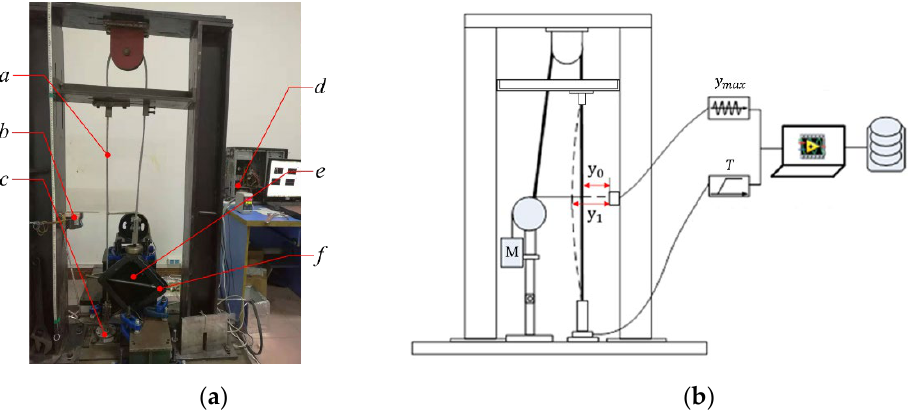
Figure 9. Test setup for the free bending deformation tests: ( a ) experimental setup; ( b ) schematic diagram of the experimental principle.